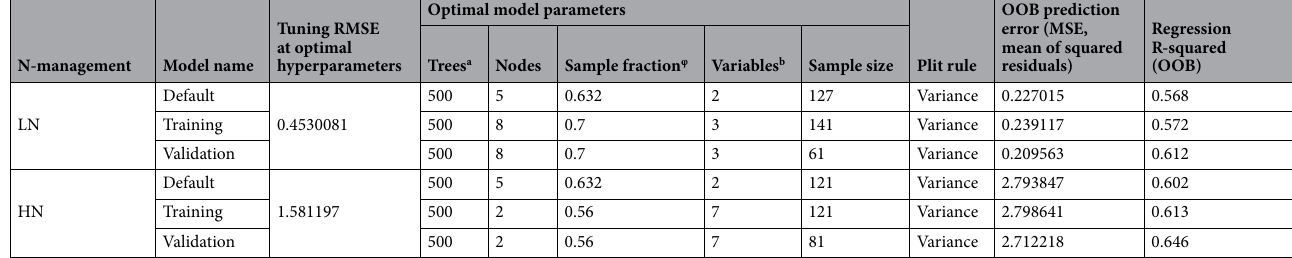
Table 1. Summary of model evaluation and test (validation) by random forest machine learning. a Trees maintained at 500 since all optimal trees (in Fig. 2) fell within this limit. b Number of predictor root traits sampled at each tree node; HN, high N; LN, low N. The validation sample was kept independent of the training sample, and the same hyperparameters were applied as for the training model. ϕ